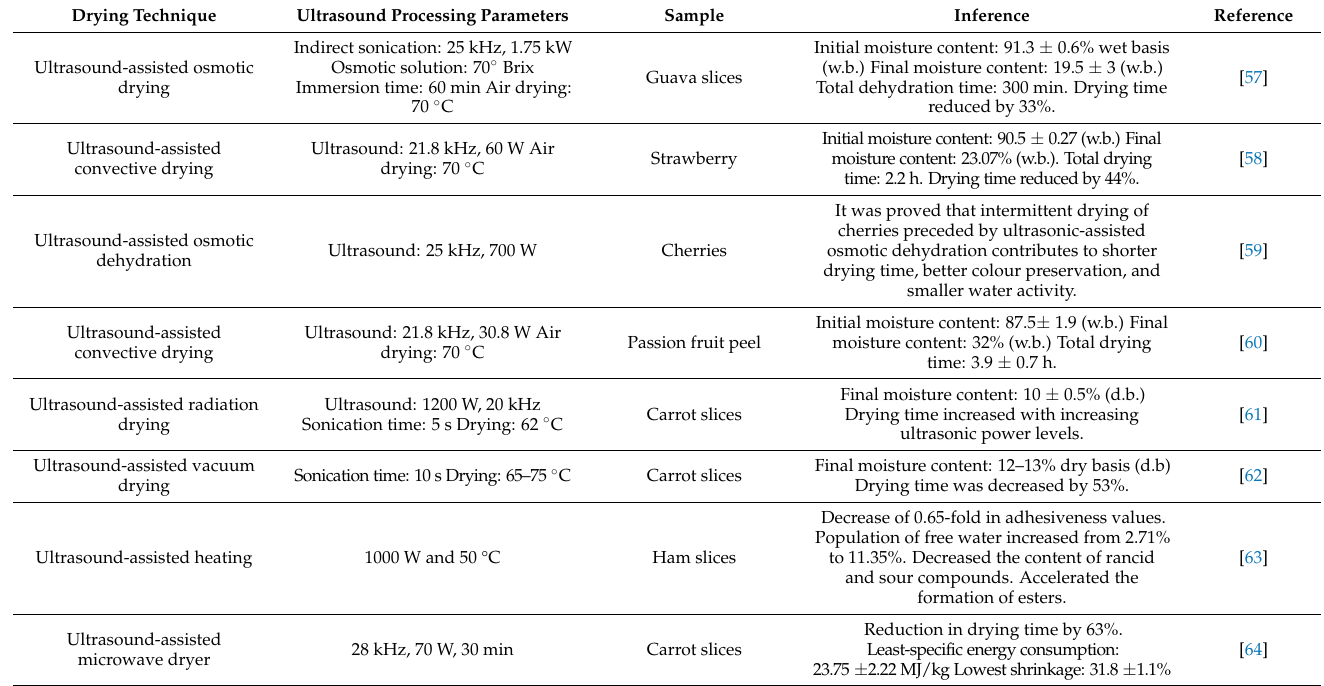
Table 2. Effect of ultrasound during